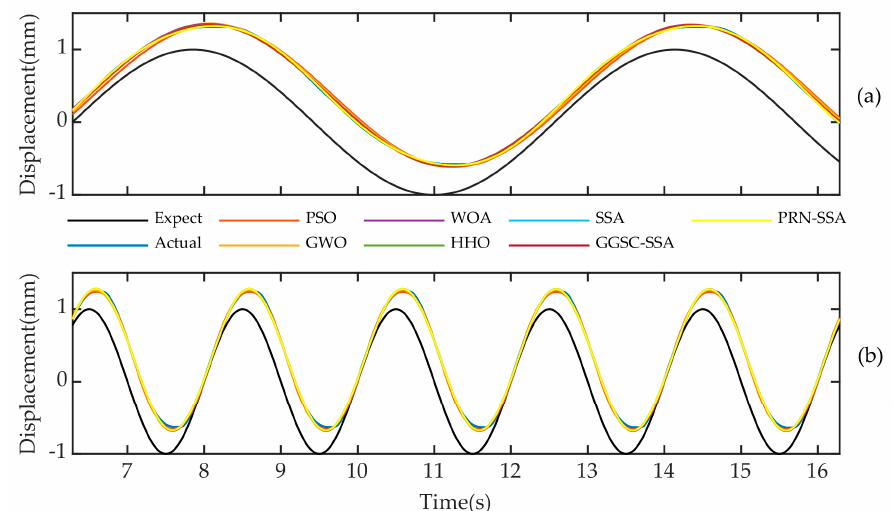
Figure 14. The actual output of the system and the simulation curve of the system output are identified by each algorithm (sinusoidal signal): ( a ) Period is 2 π ; ( b ) Period is 0.5 π